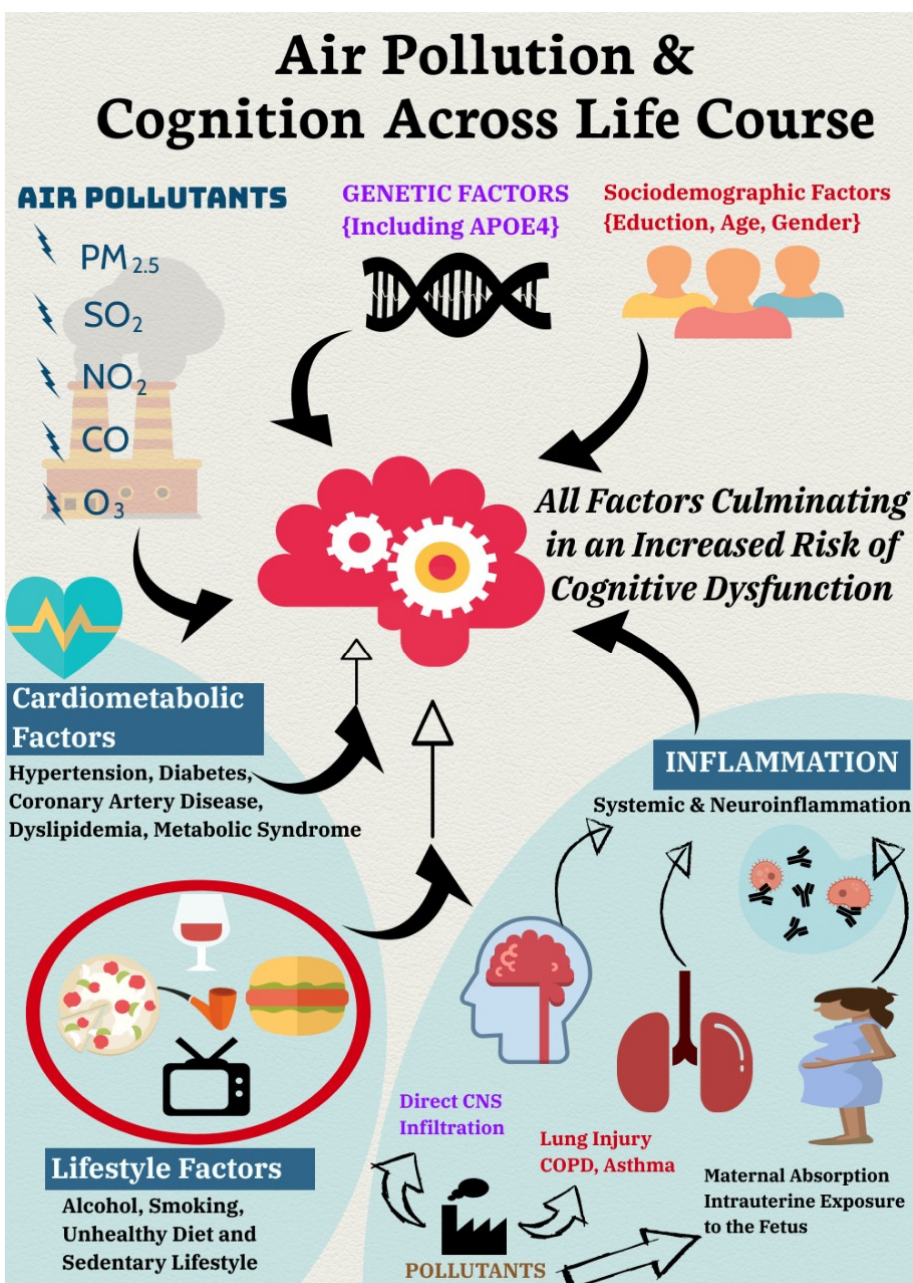
Figure 4. Proposed aetio-pathological mechanisms of cognitive impact from air pollution across the life course.(made using piktochart.com)